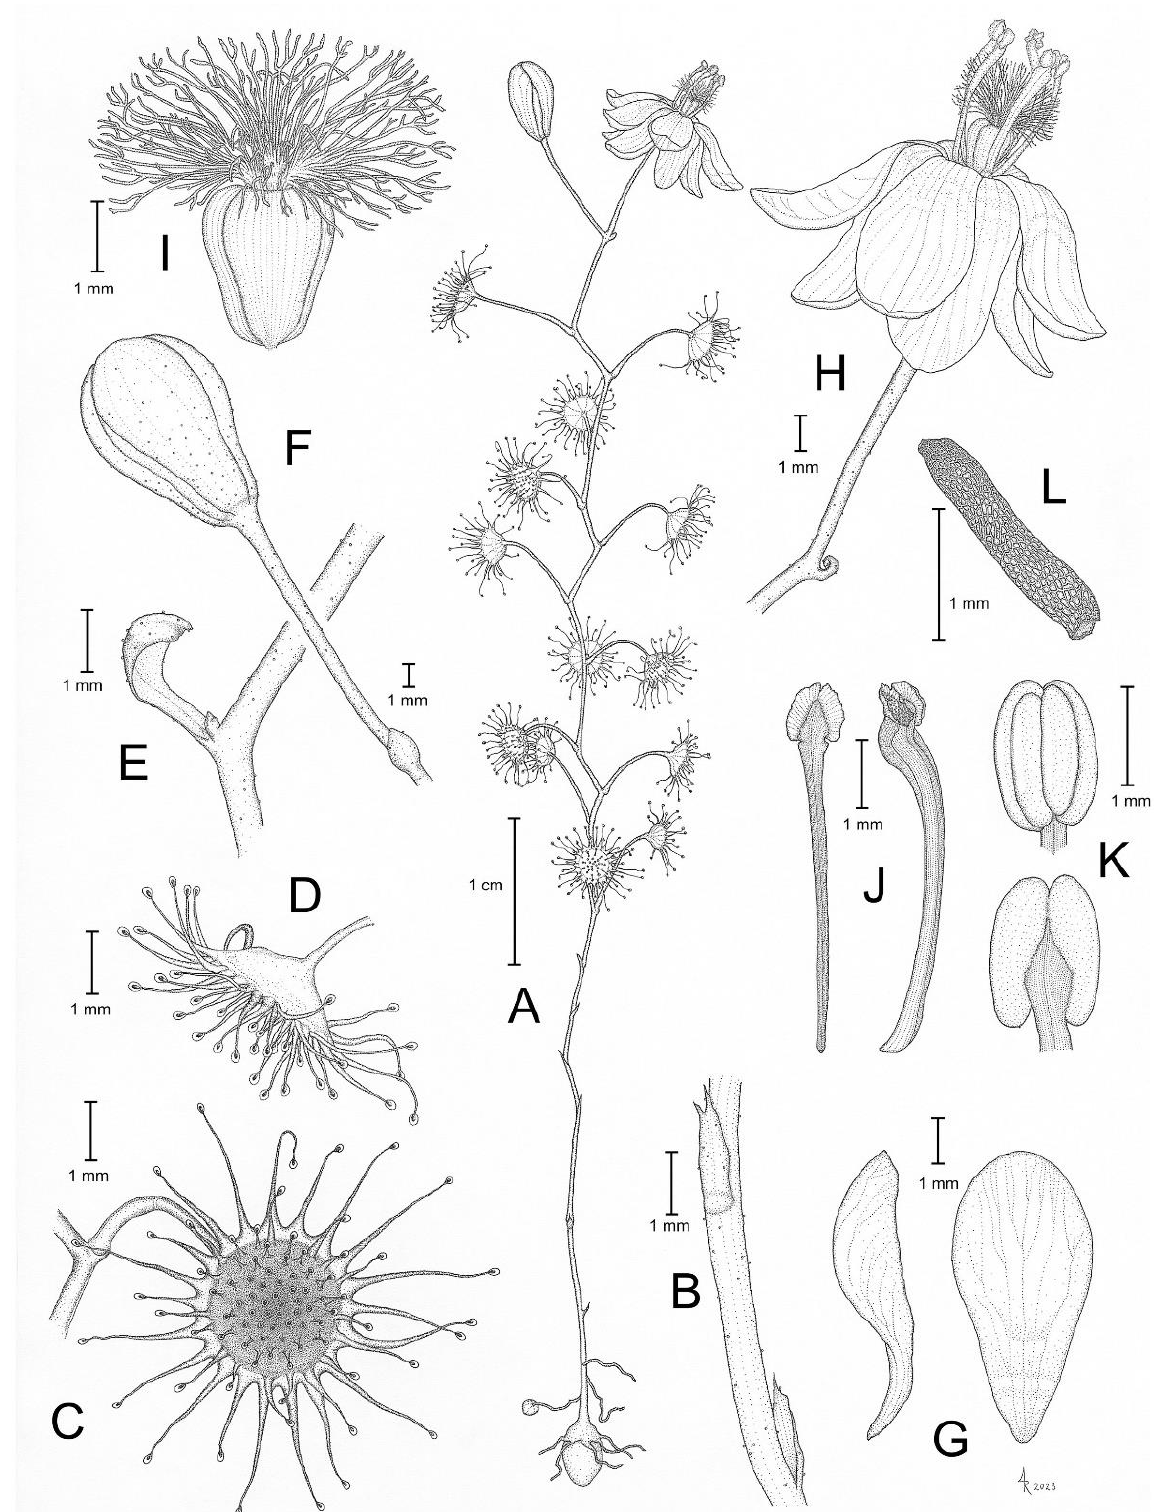
Figure 15. Drosera reflexa G.Bourke & A.S.Rob. ( A ) habit (tunic not depicted); ( B ) stem base with two cataphylls; ( C ) lamina, adaxial view; ( D ) lamina, lateral view; ( E ) peduncle and bract; ( F ) pedicel and flower in bud; ( G ) petals, left side view, right adaxial view; ( H ) flower, lateral view; ( I ) gynoecium; ( J ) stamens, left dorsal view, right lateral view; ( K ) thecae, top ventral view, bottom dorsal view; and ( L ) seed. ( A – K ) from the type ( G.J. Bourke 458 , spirit material), ( L ) from SEM images. Drawing: A. Robinson.